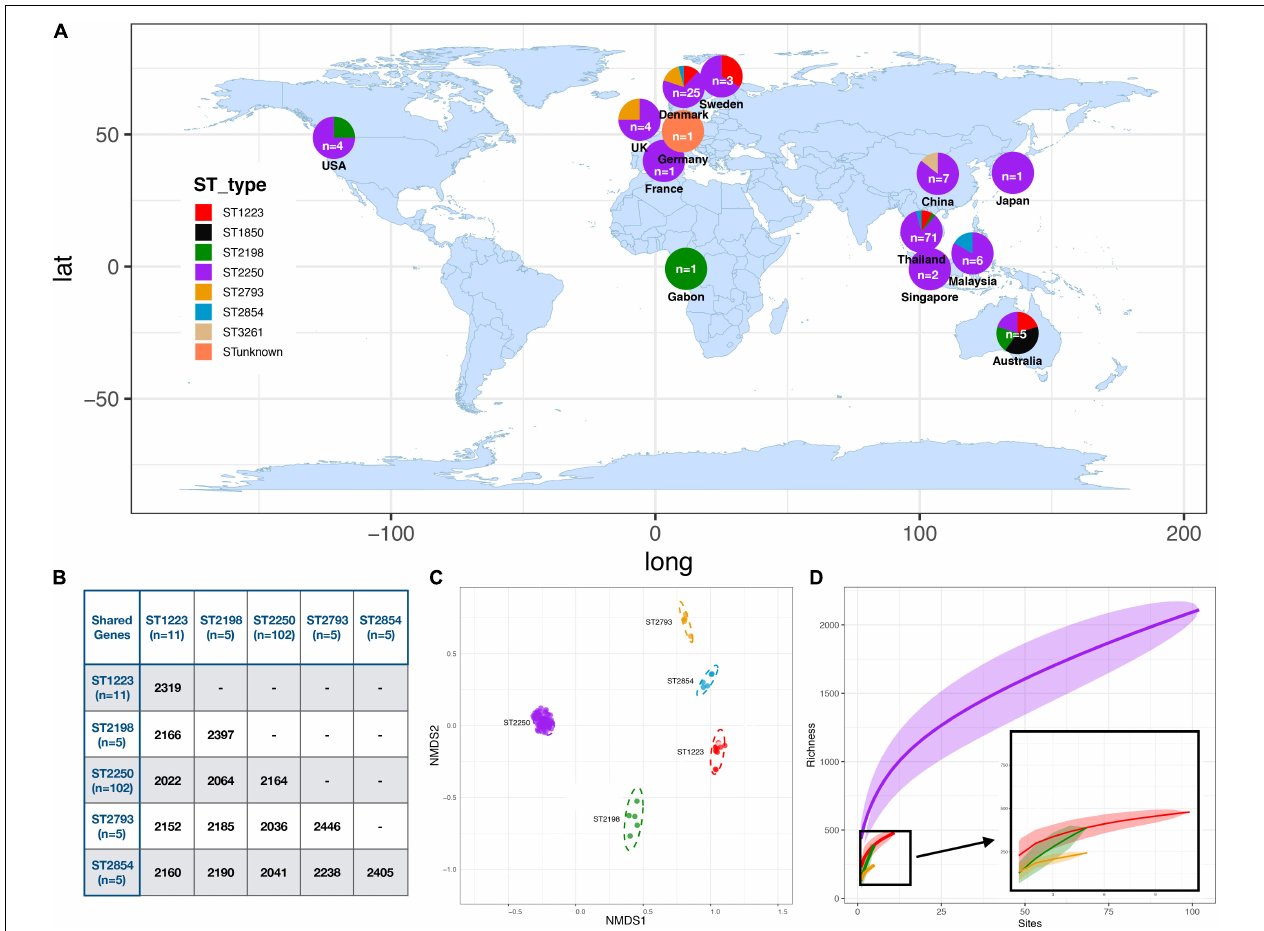
FIGURE 1 | Distribution and Relatedness of Global S. argenteus strains (A) Distribution of S. argenteus ST within the global collection studied. The proportion of each ST within each location is shown within the overlaid pie chart. (B) Table showing the number of shared core genes (found in ≥ 99% of a specific strain) between different pairs of S. argenteus STs. (C) Non-metric Multi-dimensional Scaling (NMDS) plot for gene diversity of accessory genes within and between dominant STs, based on Jaccard distance. Each dot represents an isolate colored with its ST according to the legend in (A) . (D) Gene accumulation curves for different STs of S. argenteus. STs are colored according to the key in panel (A) . For ST2250, the Heaps co-efficient is 0.69, indicating an open